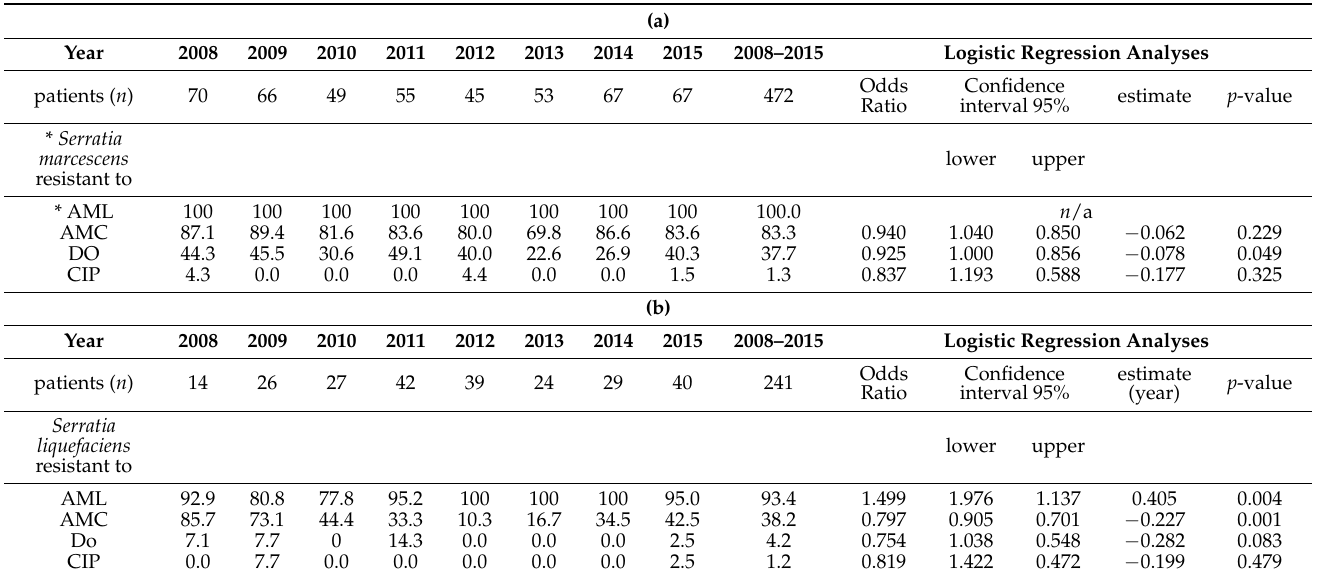
Table 2. ( a ) Temporal evolution (2008 to 2015) of the occurrence of antibiotic resistances to amoxicillin (AML), amoxicillin/clavulanic acid (AMC), doxycycline (DO), ciprofloxacin (CIP) was analyzed using logistic regression methods. Trend in the occurrence of antibiotic resistances (%) in Serratia marcescens . ( b ) Temporal evolution (2008 to 2015) of the occurrence of antibiotic resistances to amoxicillin (AML), amoxicillin/clavulanic acid (AMC), doxycycline (DO), ciprofloxacin (CIP) was analyzed using logistic regression methods. Trend in the occurrence of antibiotic resistances (%) in Serratia liquefaciens . (a)